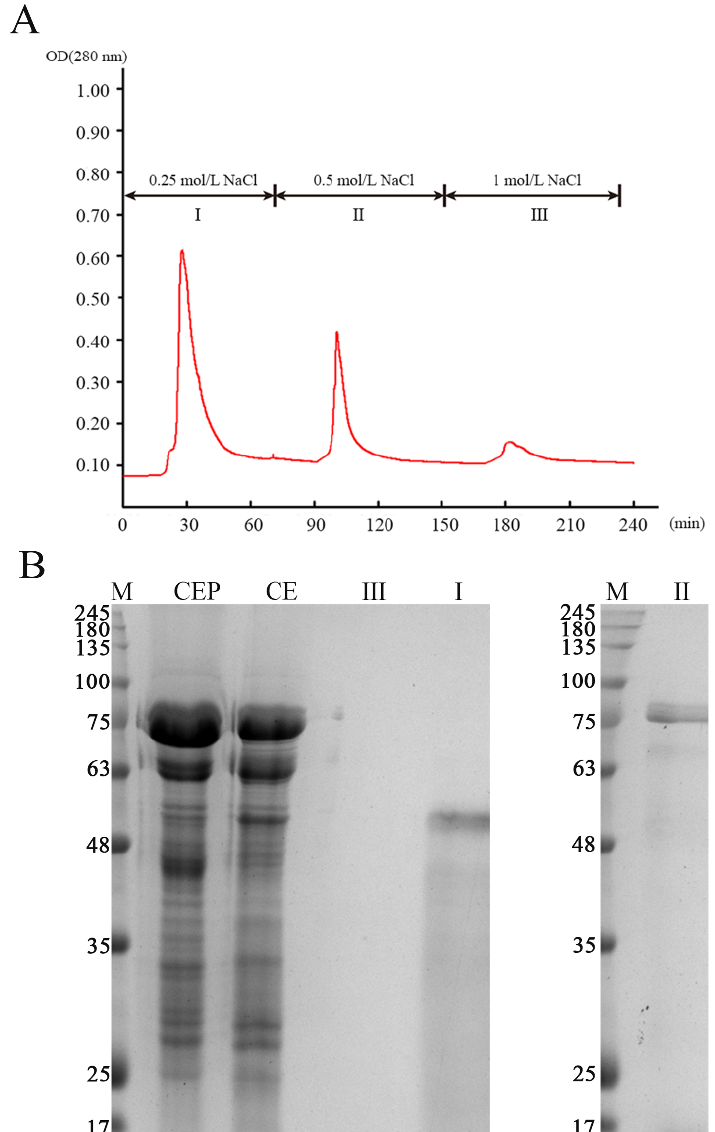
Figure 7. The purification of endogenous protease from shrimp head: ( A ) endogenous proteases were separated and purified by DEAE–Sepharose fast flow and ( B ) the SDS–PAGE analysis of endogenous protease from shrimp head. CE, SH crude extract; CEP, crude endogenous protease. Table 5. A summary of the purification of endogenous protease on the extract from shrimp heads.